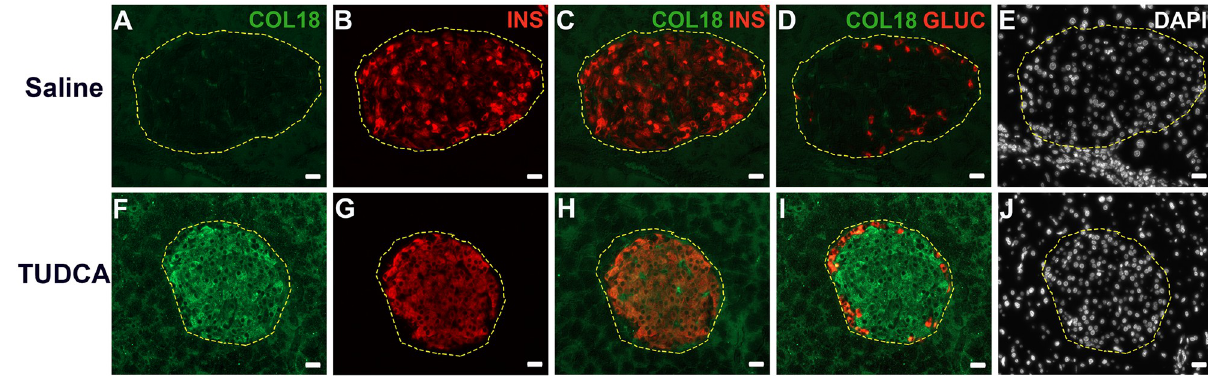
Fig 9. TUDCA treatment restores the colocalization of intra-islet COL18 core protein and insulin in db/db pancreas. Immunofluorescence staining of ( A, F ) COL18, ( B, G ) insulin (INS), ( C, H ) insulin and COL18 merged, ( D, I ) glucagon (GLUC) and COL18 merged in ( A-D ) saline-treated control and ( F-I ) TUDCA-treated db/db pancreases. ( E, J ) DAPI was used to identify nuclei. Scale bar = 20 μ m.